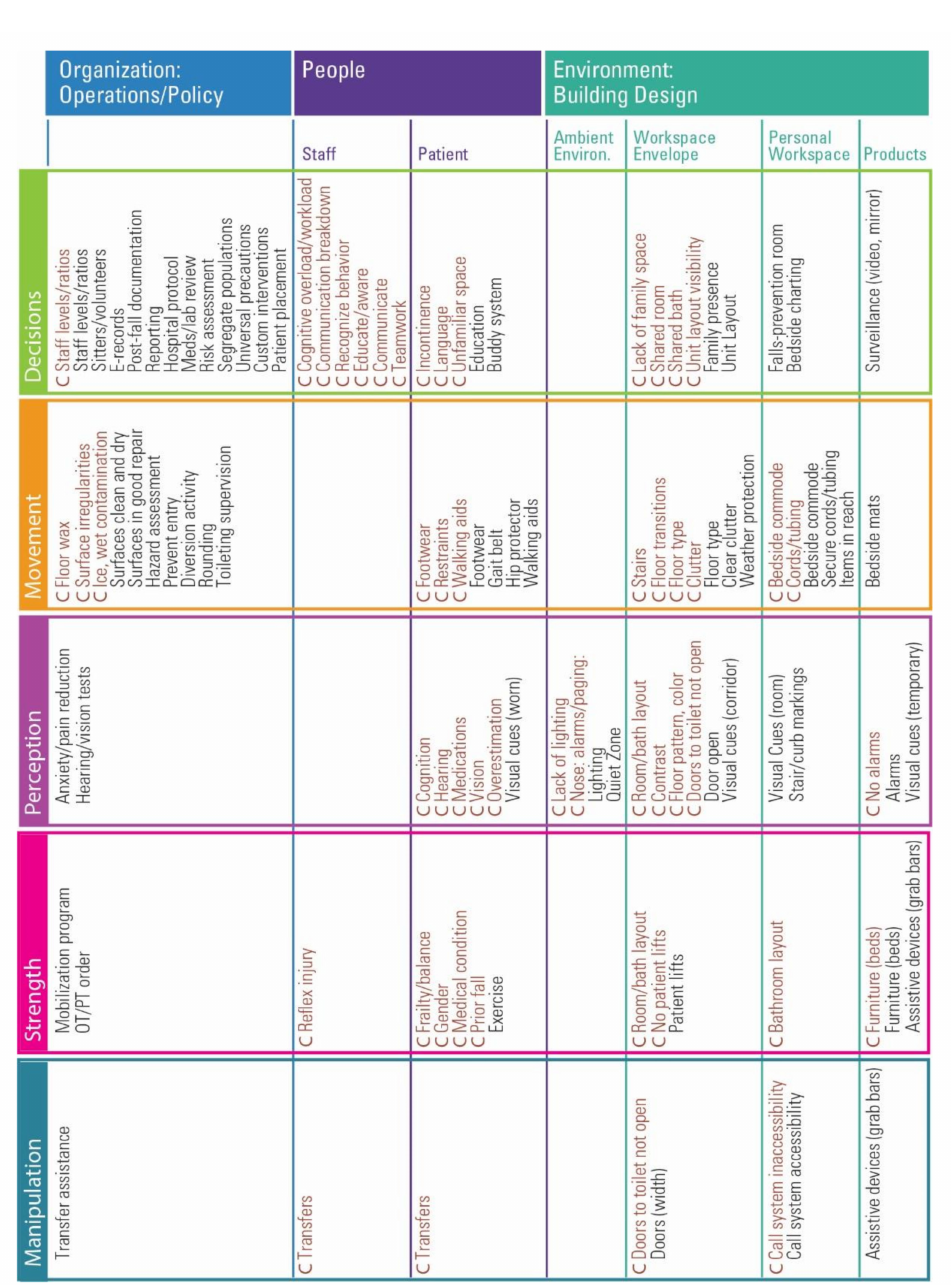
Figure 3. The DEEP SCOPE Matrix for Falls. (C: Correlated for